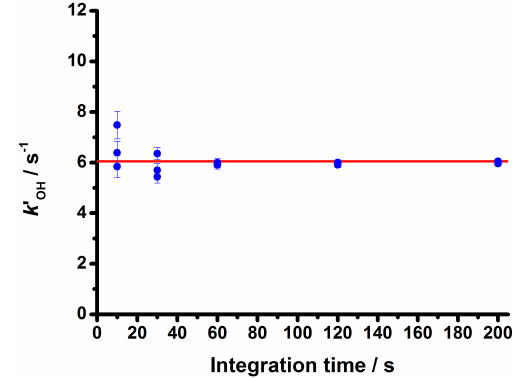
Figure 11. Observed OH reactivities, for a fixed gas composition (for which the expected OH reactivity is shown in red), as a func- tion of averaging time, obtained using 15mW of 308nm probe laser